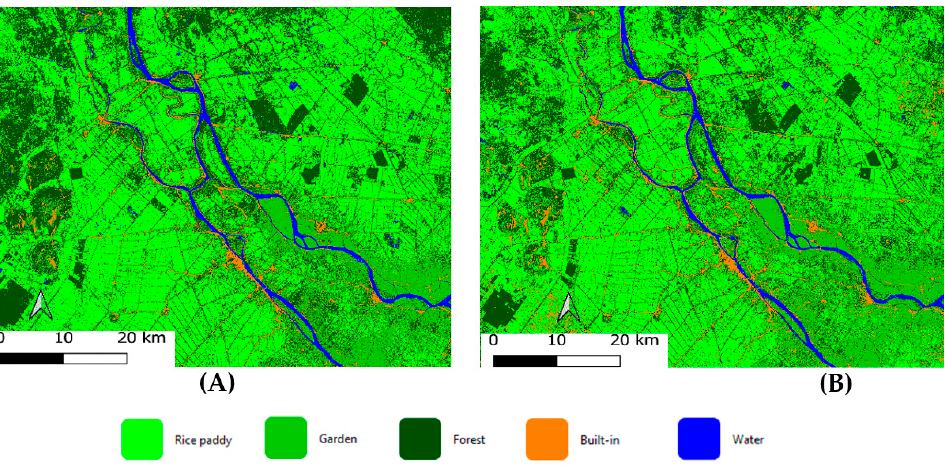
Figure 11. Land use/land cover (LULC) before the wet season ( A ) 2019 and ( B ) 2020 by CNN classi-